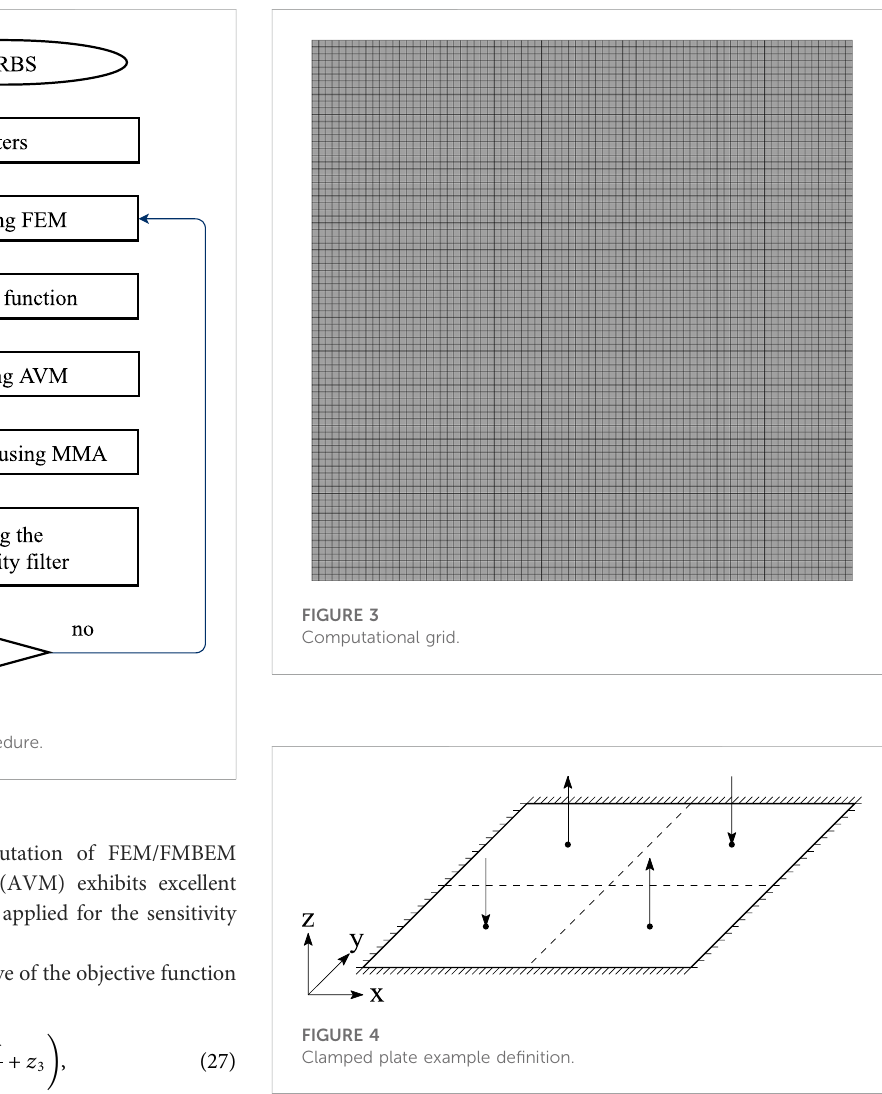
FIGURE 4 Clamped plate example de fi